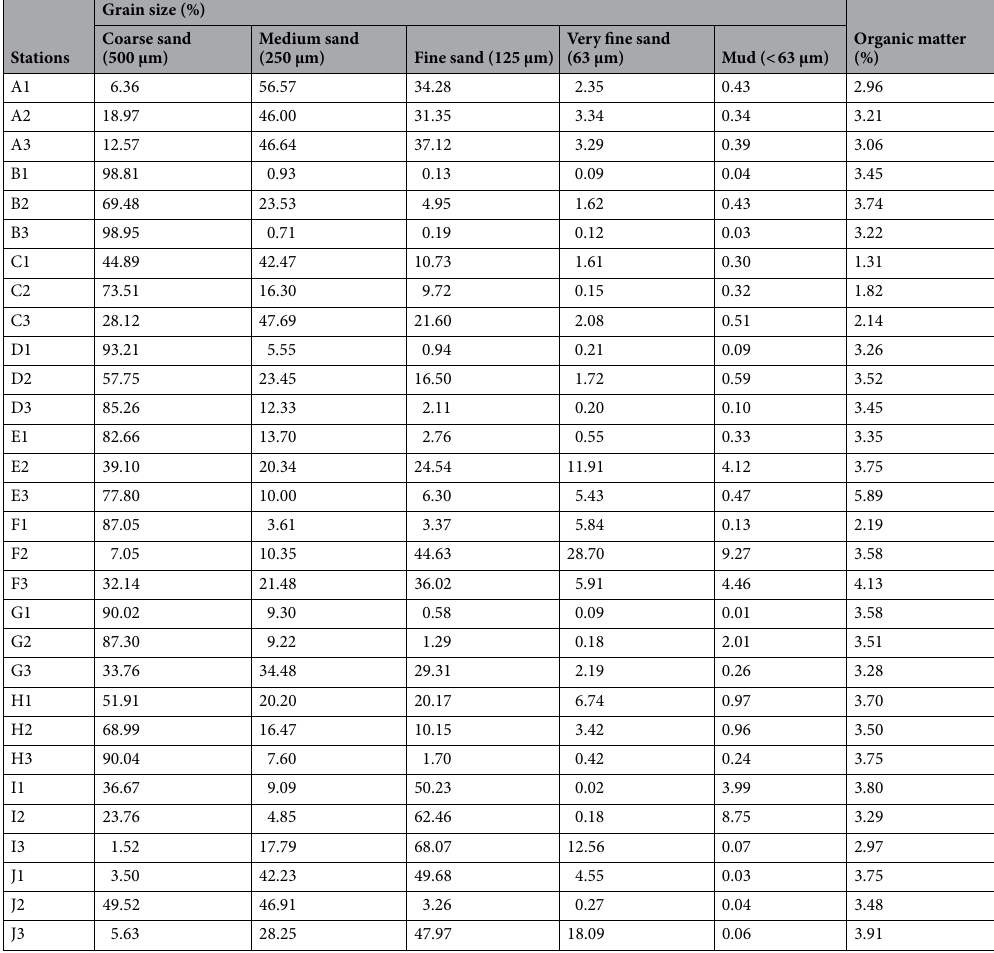
Table 3. The composition of sediment grain size and organic matter around Pulau